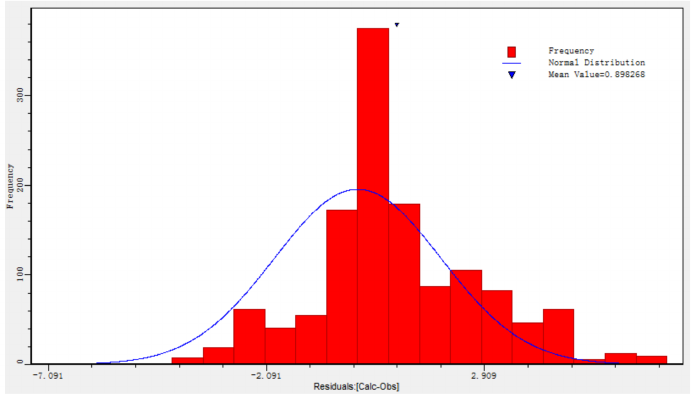
Figure 8. Distribution of water-level fitting errors during the calibration period.